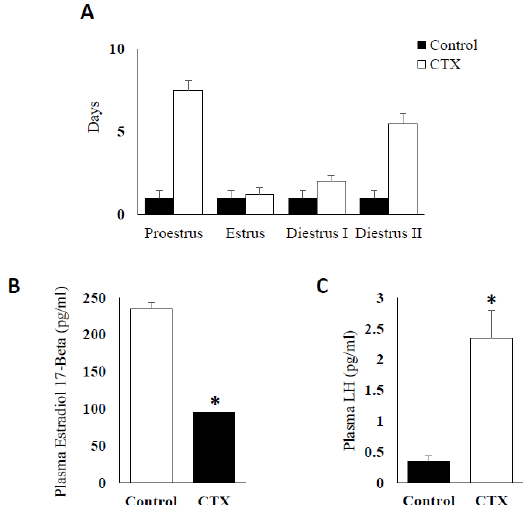
Figure 1. Effect of chemotherapy treatment on estrus cycle and steroidogenesis. ( A ) Effect of CTX (Chemotherapy) on estrus cycle length; ( B ) comparison of plasma estradiol 17-β concentrations presented in pg/mL between CTX-treated mice group and control group at Proestrus stage (* p < 0.05); ( C ) plasma LH (Luteinizing hormones) levels presented in pg/mL and compared between CTX-treated mice group and control group at Proestrus stage (* p <